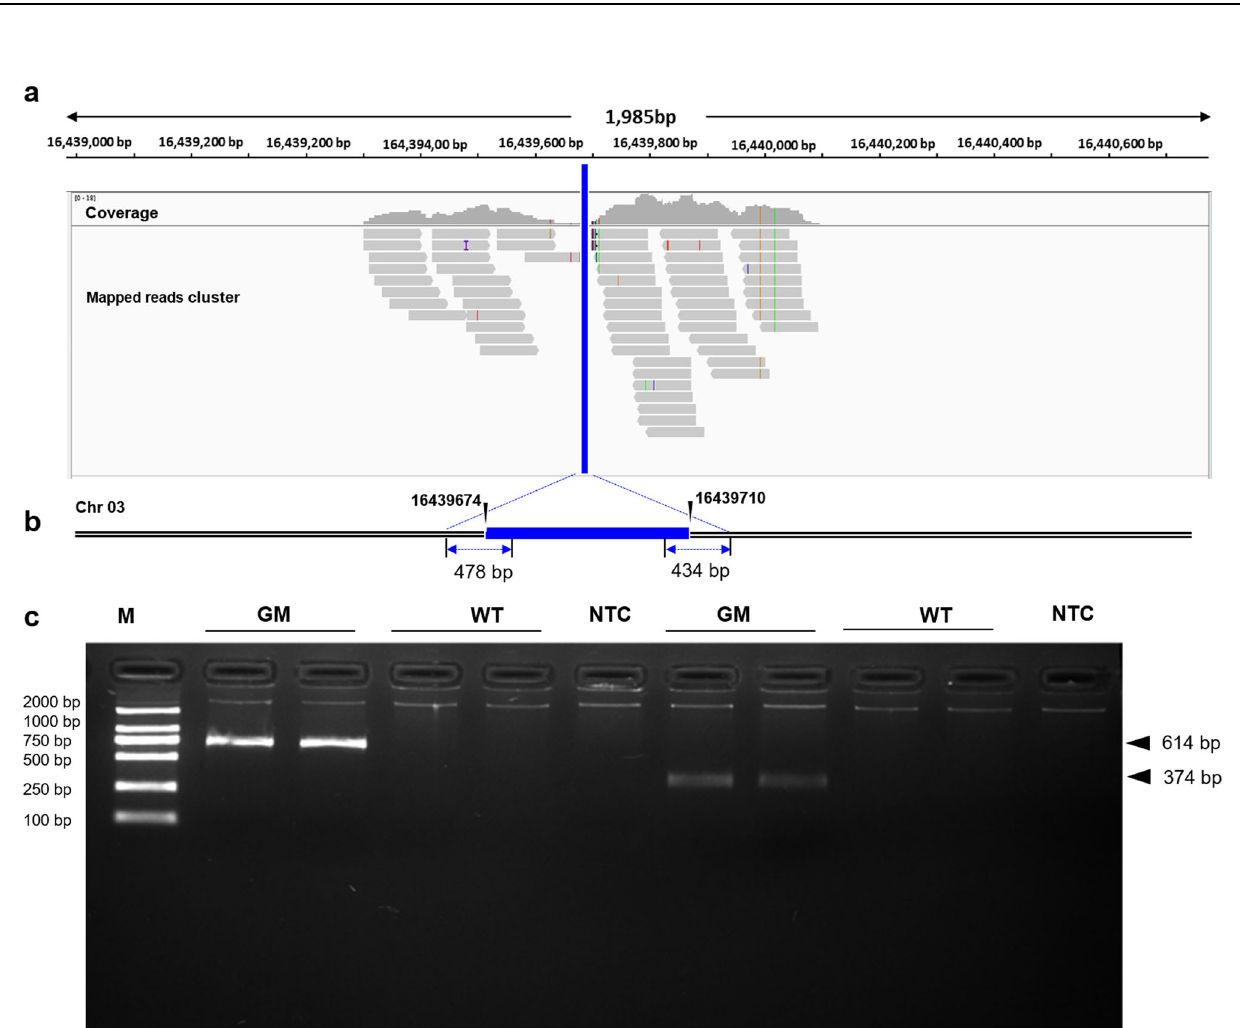
Fig. 2 The transgene integration site and its fl anking sequence from PE-WGS and PCR analyses. a IGV view of 69 candidate read pairs crossing the insertion site of chromosome 3. The red line indicates the transgene insertion site in the rice genome. b Location of the transgene integration site according to the assembled contigs from candidate read pairs. c Conventional PCR ampli fi cation results for the fl anking sequence. Lane M, DNA marker with six DNA fragments of 100, 250, 500, 750, 1000, and 2000bp, respectively; Lane GM, G281; Lane WT, Xiushui 110; Lane NTC, no template